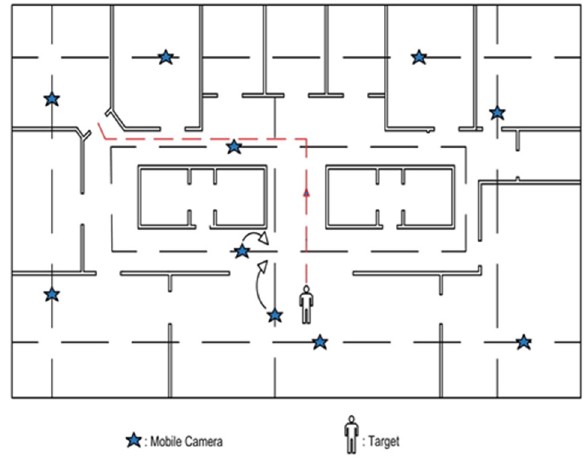
Figure 1. An example of cooperative relay tracking and prediction of targets is in the mall . As we can see, in this scenario, the target is moving from one shop to another. His future path is illustrated by the red line in the fi gure. Whenever the target is moving, the camera closest to it is also moving to keep up with the target’s activities. When the target passes across an intersection point where more than one camera is available, the total moving distance of cameras can be reduced by using a camera relay. Based on the target’s prior movements, the prediction pa tt ern is used to predict the target’s upcoming movement. When the target moves, only the chosen camera will be active, and its movement is determined by the cooperative relay algorithm, which is utilized to reduce the total movement distance of cameras.